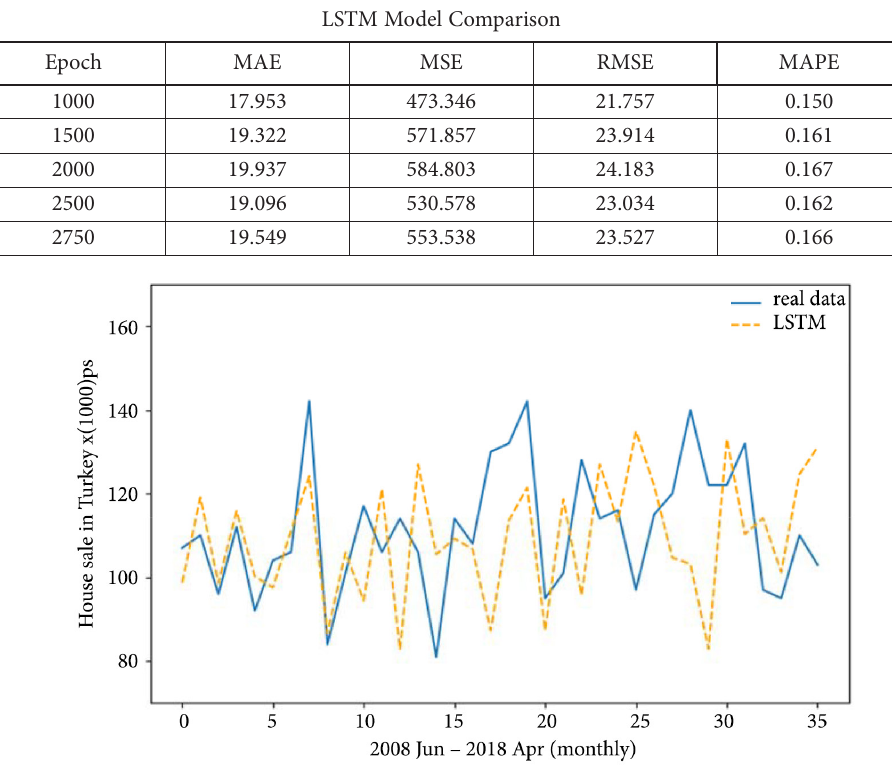
Figure 6. LSTM model (1000 epoch) and ground